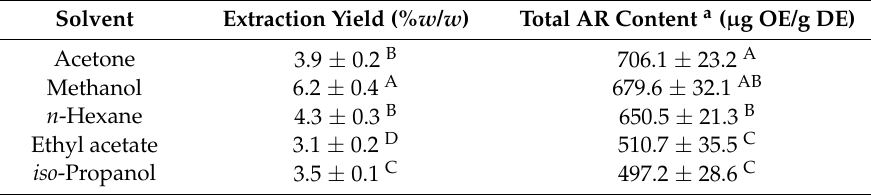
Table 1. n -Alkyl(enyl)resorcinol (AR) extraction using different organic